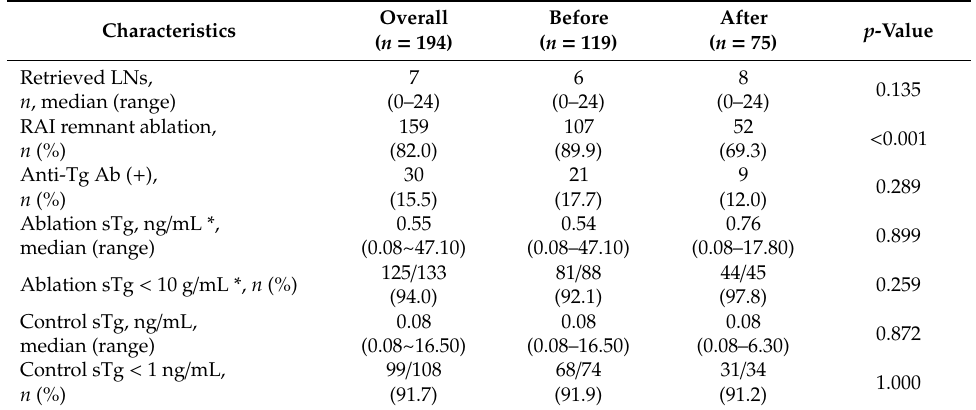
Table 3. Surgical completeness of robotic thyroid surgery, overall, before, and after the learning curve